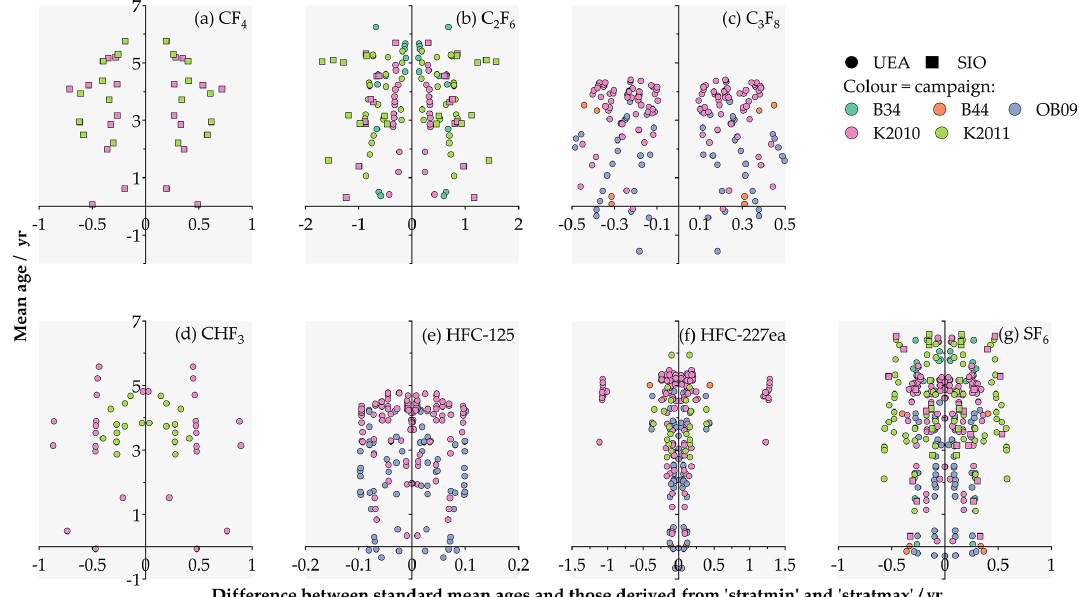
Figure 2. Residual plots showing the uncertainties associated with varying the stratospheric measurement inputs for the AoA routine. The x axis shows the difference between the mean ages calculated using a minimum and maximum stratospheric mixing ratio compared to using the mean mixing ratio normally used, the mean age of which is on the y axis (Sect. 3(b); cases 8 and 9 in Table S1). The marker shape denotes which institution performed the analysis and the marker colour the stratospheric campaign; see inset legend. The vertical axis labels for each row are in the left